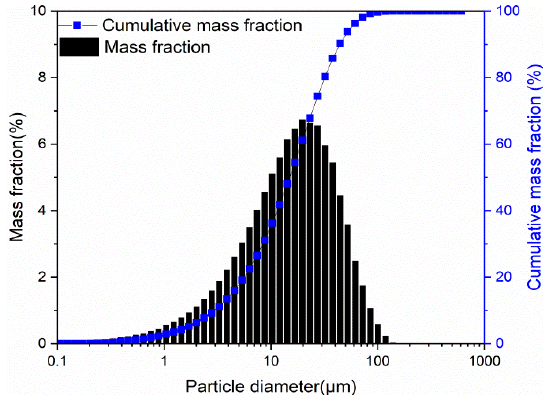
Figure 6. Particle size distribution in the experiment.